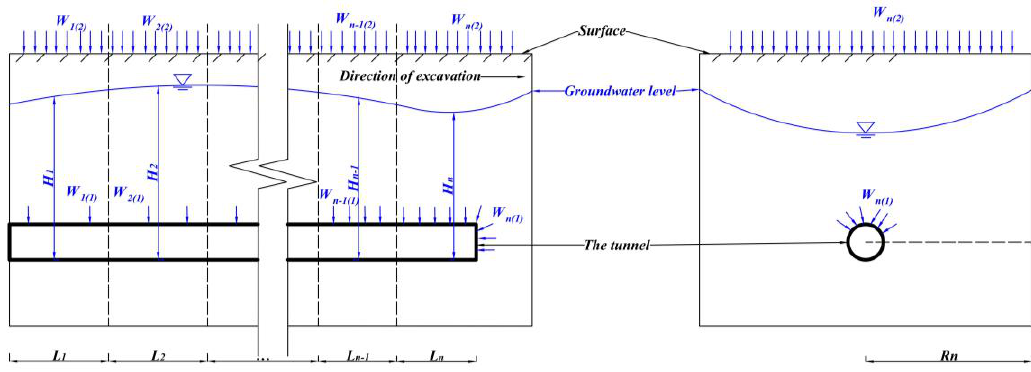
Figure 1. Example diagram of a tunnel section.